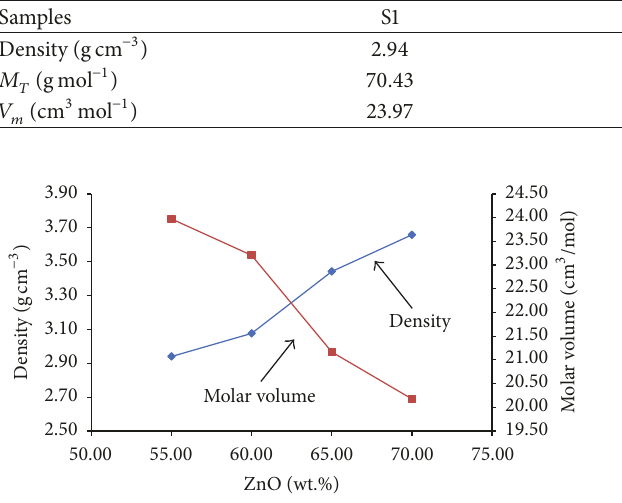
Figure 1: The density and molar volume versus wt.% of ZnO in ZnO–SiO 2 samples.